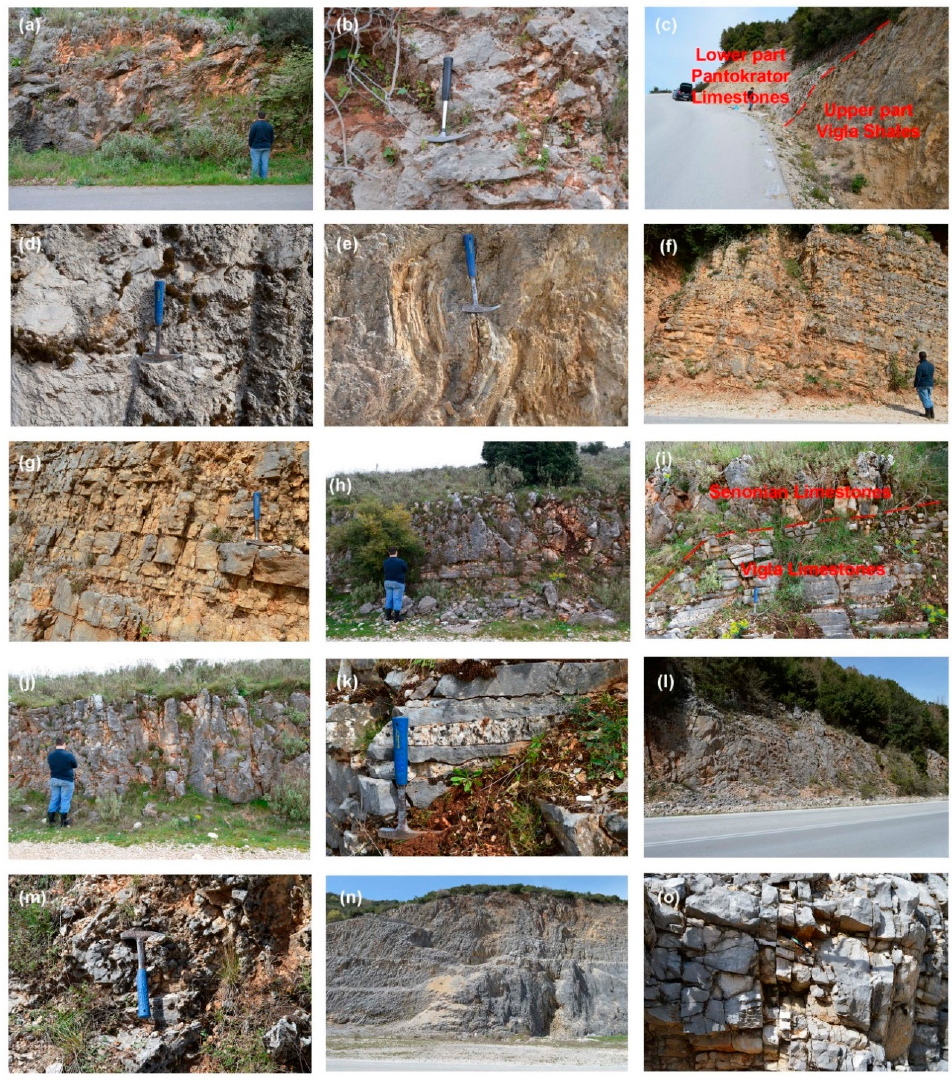
Figure 5. Outcrop photographs of the study sections along with enlargements indicative of their characteristics: ( a ) General panoramic view of the Agios Georgios section; ( b ) Early Jurassic Pantokrator Limestones of Agios Georgios section; ( c ) general panoramic view of Perivleptos section. The red dashed line marks the unconformity between the lower (Pantokrator Limestones) and the upper (Vigla Shales) part of the section; ( d ) Pantokrator Limestones of the lower part of Perivleptos section; ( e ) Vigla